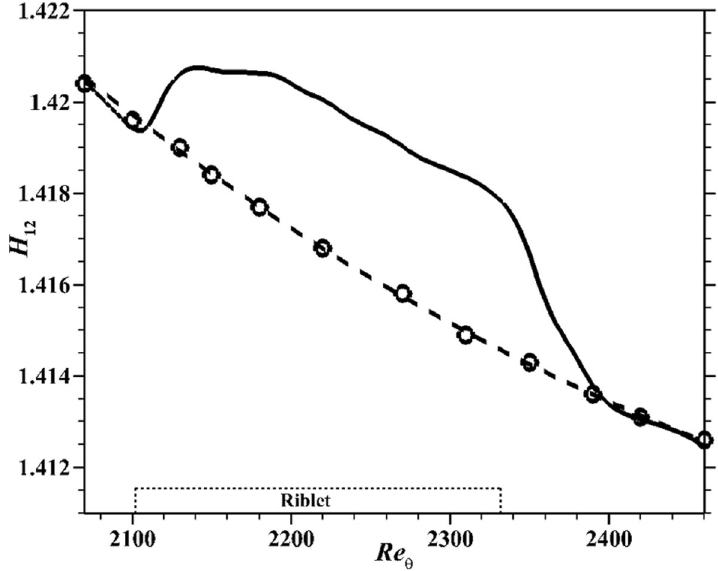
Fig. 6 Spatial development of the boundary-layer shape factor H 12 (The solid and dashed lines indicate the riblets case and smooth case, respectively. The circle symbol is the results of Schlatter et al.